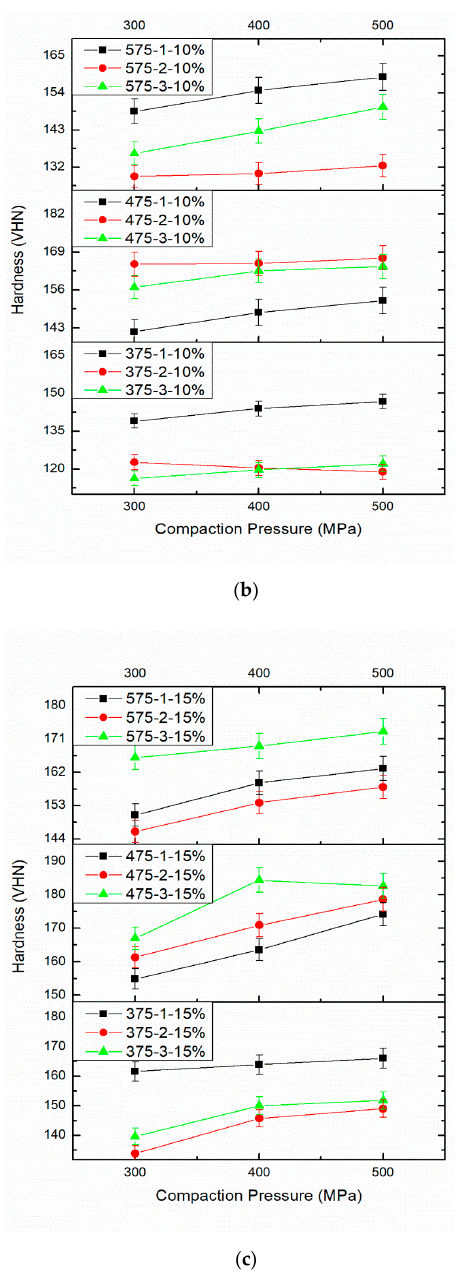
Figure 8. ( a ). Effect of different compaction pressure (300, 400, and 500 MPa), different sintering time (1, 2, and 3 h), sintering temperature (375 ◦ C, 475 ◦ C, and 575 ◦ C), and 5 wt%.B 4 C on micro hardness. ( b ). Effect of different compaction pressure (300, 400, and 500 MPa), different sintering time (1, 2, and 3 h), sintering temperature (375 ◦ C, 475 ◦ C, and 575 ◦ C), and 10wt%.B 4 C on micro hardness. ( c ). Effect of different compaction pressure (300, 400, and 500 MPa), different sintering time (1, 2, and 3 h), sintering temperature (375 ◦ C, 475 ◦ C, and 575 ◦ C), and 15 wt%.B 4 C on micro